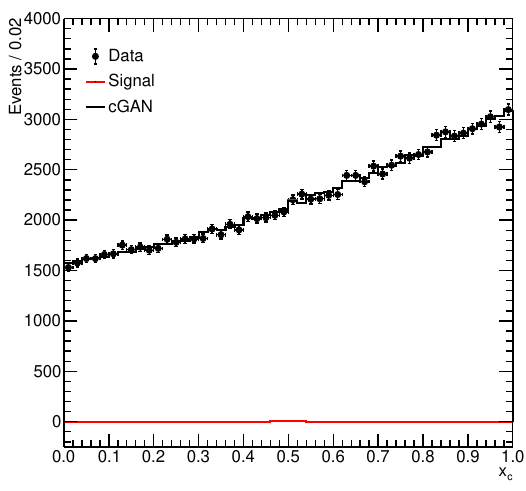
Figure 17 . Post-fit x c distributions for a fit to the background-only dataset of one of the ensemble tests. The error bars on the markers represent the statistical uncertainty on the mock data. The sum of the signal and background models (upper red curve) and the signal model alone (lower red curve) are also